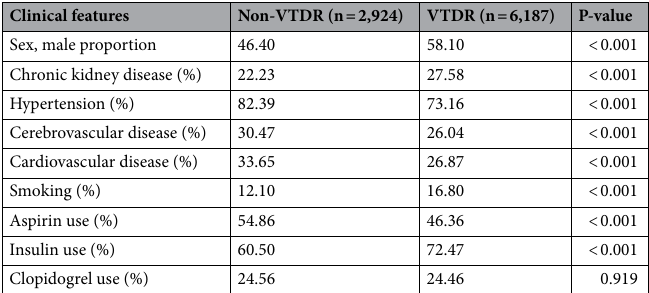
Table 2. Summary of clinical features (categorical variables) of type 2 diabetic patients with and without vision-threatening diabetic retinopathy in datasets of 10-year. VTDR vision-threatening diabetic retinopathy. P-value: Chi-square test between non-VTDR and VTDR.